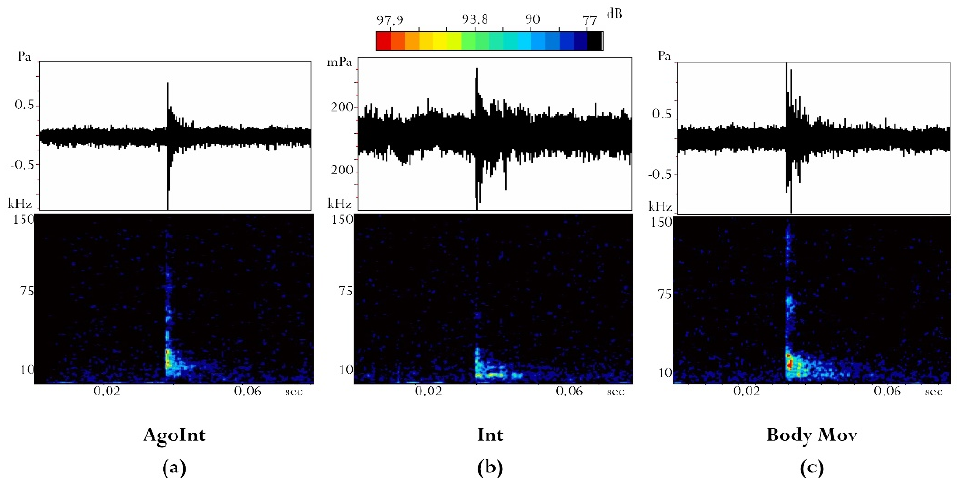
Figure 4. Example of waveforms and spectrograms of impulsive signals emitted during: ( a ) Agonistic Interaction (AgoInt), ( b ) non − agonistic Interaction (Int), and ( c ) Body Movements (BodyMov). FFT length 512 points, Hann window, frequency resolution 586 Hz. Graphs were realized with Avisoft SAS-Lab Pro software 5.3.01 (Glienicke, Germany).